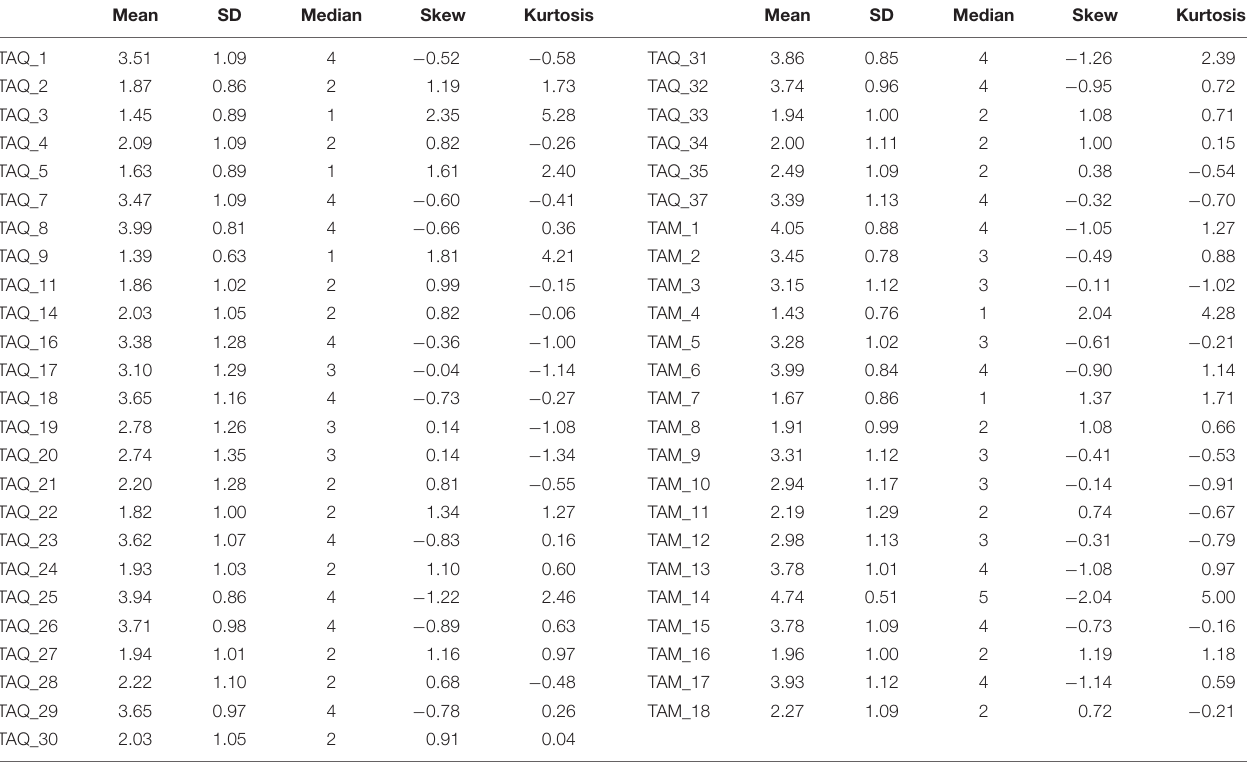
TABLE 1 | Descriptive statistics for Touch Avoidance Measure (TAM) and Touch Avoidance Questionnaire (TAQ)